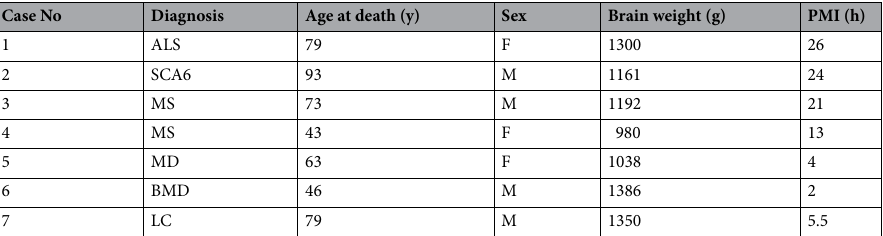
Table 1. Case profiles. ALS, Amyotrophic lateral sclerosis; BMD, Becker muscular dystrophy; F, female; LC, liver cirrhosis; M, male; MD, myotonic dystrophy; MS, multiple sclerosis; PMI, postmortem interval; SCA6, spinocerebellar ataxia